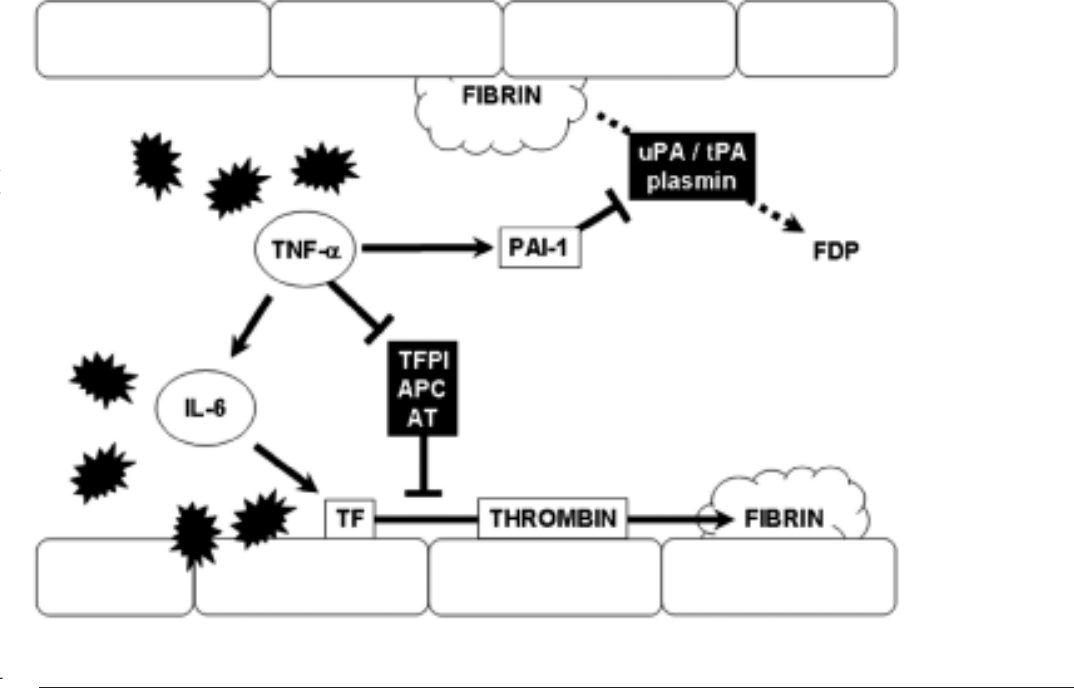
Figure 1 Inflammation-in- duced coagulation Upon intrusion by a microorganism, tissue factor (TF) up- regulation is induced on mononuclear cells (not shown in figure). Also, within hours the immune system produces a number of cytokines, such as tumour necrosis fac- tor- a (TNF- a ) and in- terleukin-6 (IL-6). IL-6 induces up-regula- tion of TF on the cell surface, causing thrombin-mediated fibrin depositions. The activation of coagulation is regu- lated by the natural inhibitors of coagula- tion, ie, tissue factor pathway inhibitor (TFPI), activated protein C (APC), and antithrombin (AT). However, TNF- a decreases the expres- sion of these in- hibitors. Finally, fibri- nolysis is inhibited (FDP, fibrin degrada- tion products), be- cause up-regulation of plasminogen acti- vator type 1 (PAI-1) suppresses plas- minogen activation (urokinase-type and tissue-type plasmino- gen activators, uPA and